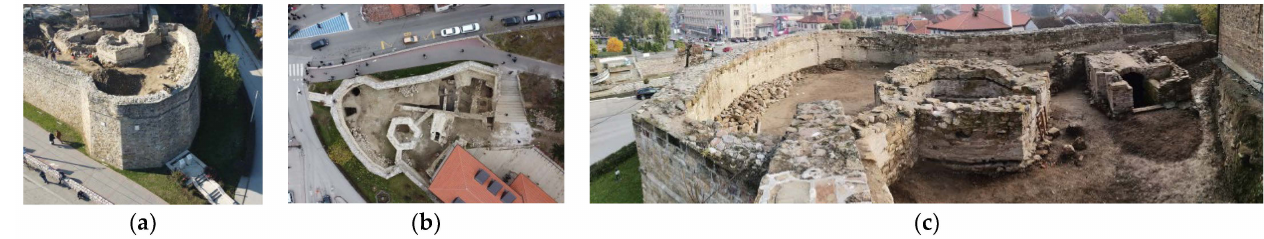
Figure 12. The remains of the tower Dzephana found on the northern Tabia, next to the dungeon. ( a ) NE-SW view; ( b ) aerial view; ( c ) on-site view (Photo source: private archive of Vladan Vidosavljevi´c). The entrance to the tower was located inside the southwestern wall and was 0.70